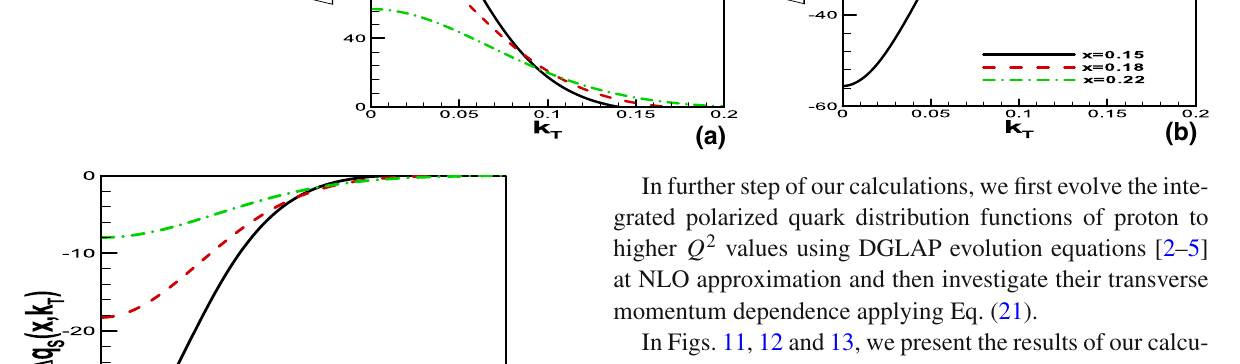
Fig. 9 The TMD polarized a up and b down valence quark distribution of proton with respect to k T at three values of x = 1 GeV 2 and Q 2 0